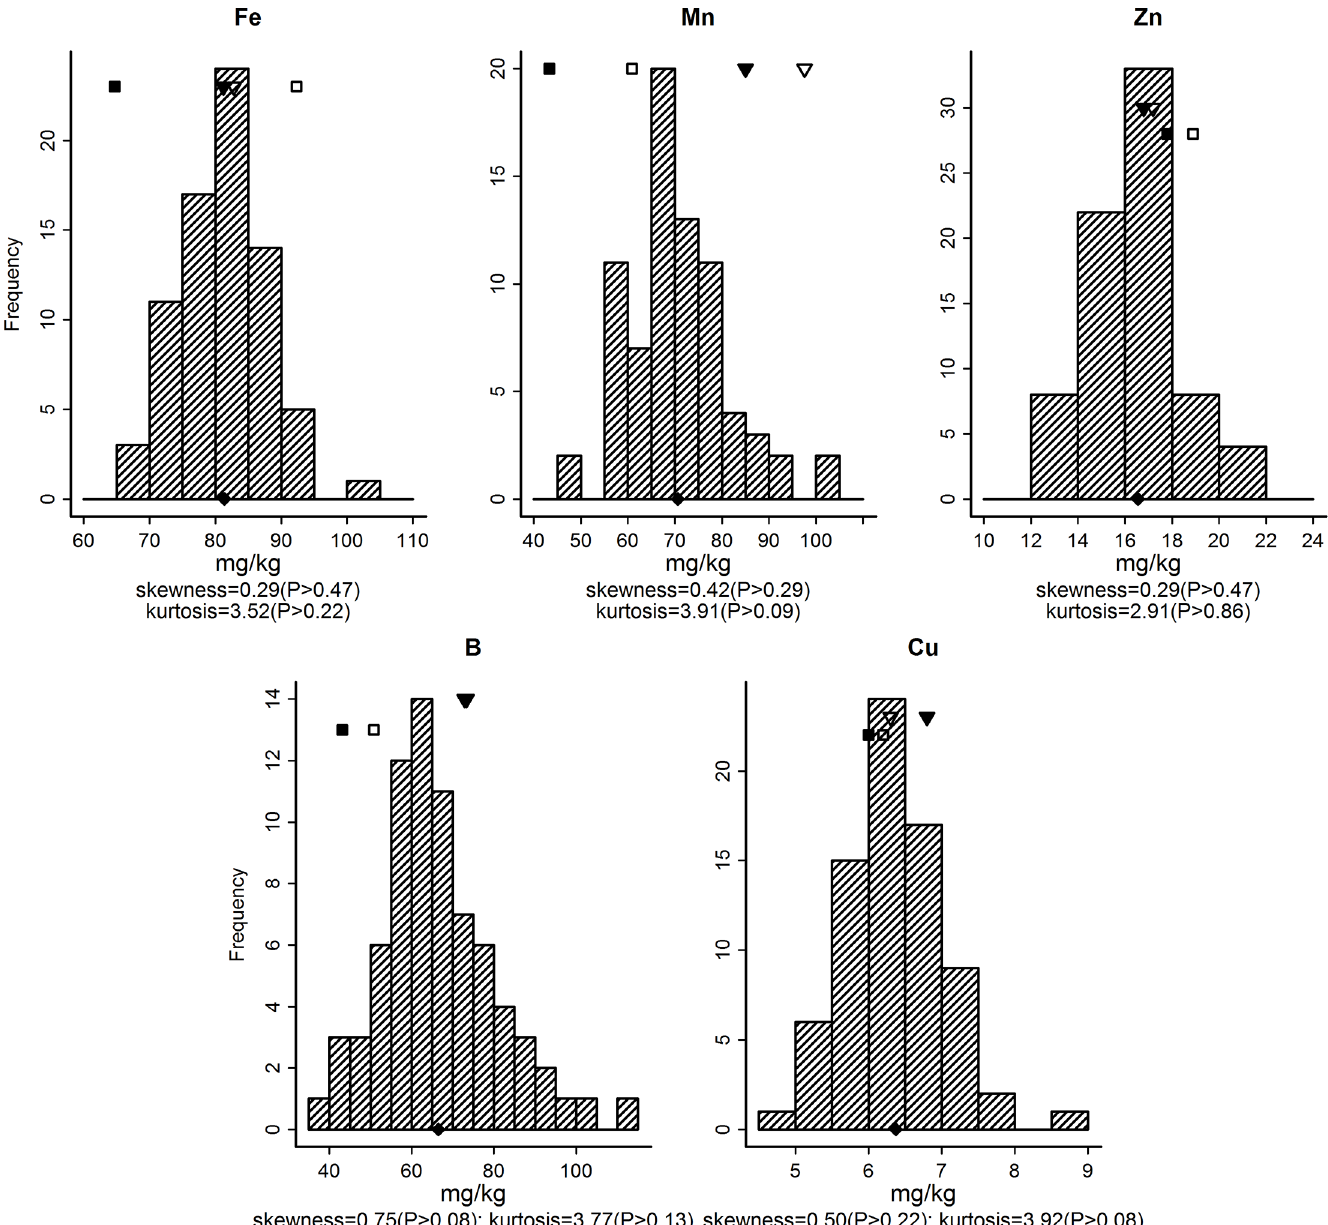
Fig 2. Distribution and normality tests of five micronutrient concentration in leaves of 77 RILs. ▼ = VH8; 5 = GUA; ∎ = Sipima 280, □ = Sicot 75; ◆ = population mean.